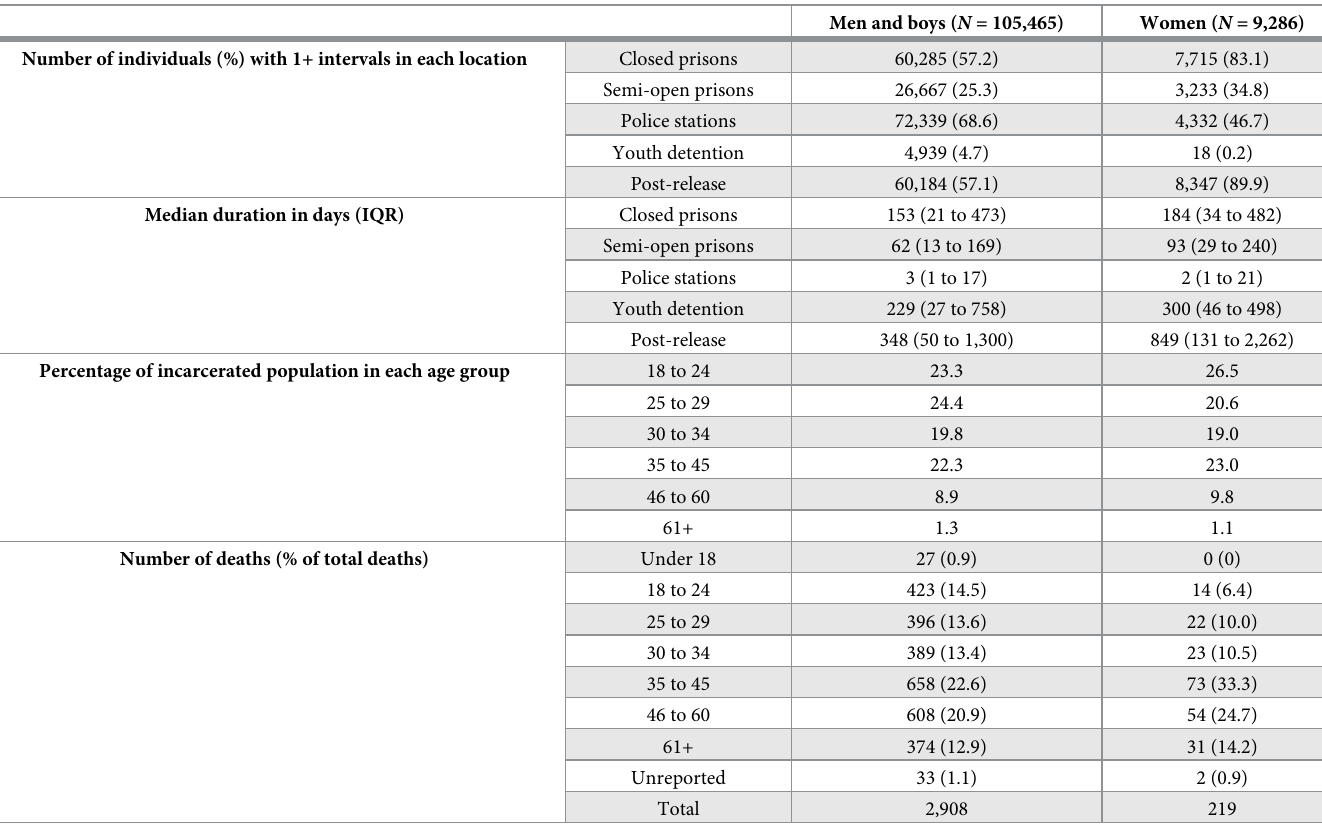
Table 1. Characteristics of study